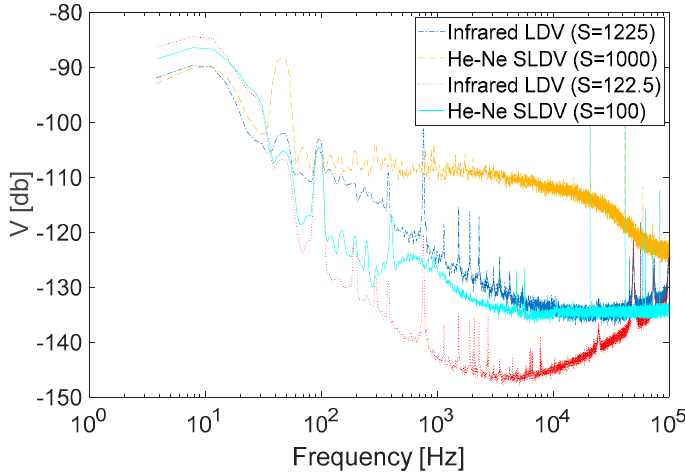
Figure 3. Noise floor comparison between He–Ne and infrared laser Doppler vibrometer (LDV); S = sensitivity (mm/s/v).